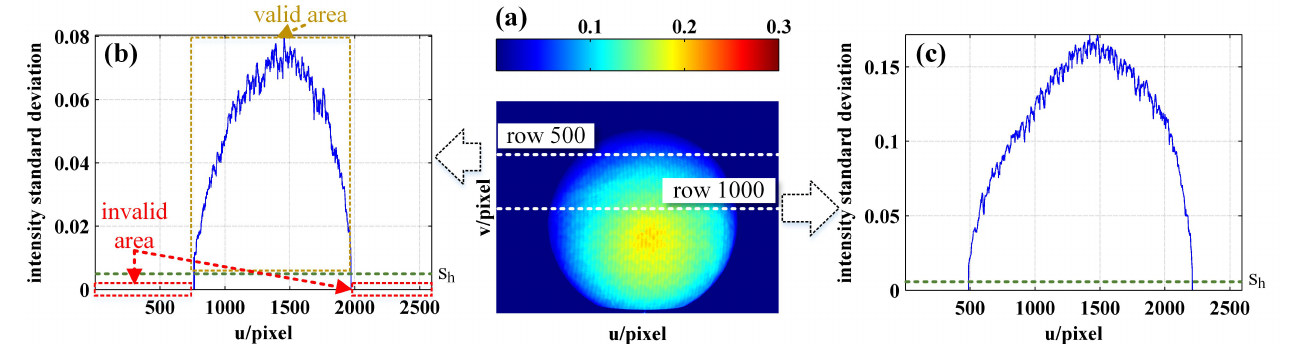
Figure 10. ( a ) Intensity standard deviation map; ( b ) the intensity standard deviation of row 500; ( c ) the intensity standard deviation of row 1000.